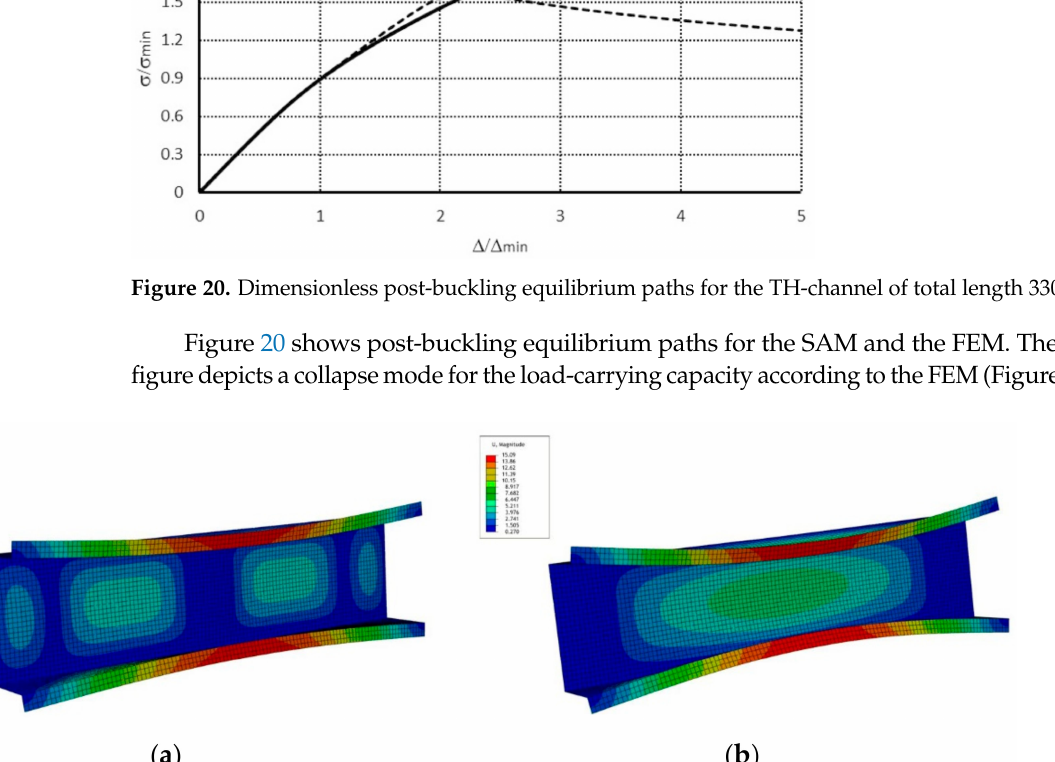
≈ 1.6 (disruption of computations) ( b σ / σ 7